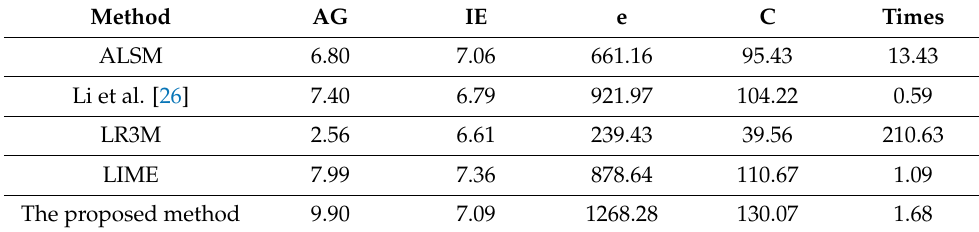
Table 5. Comparison of objective index mean values for 100 video image enhancements by differ- ent